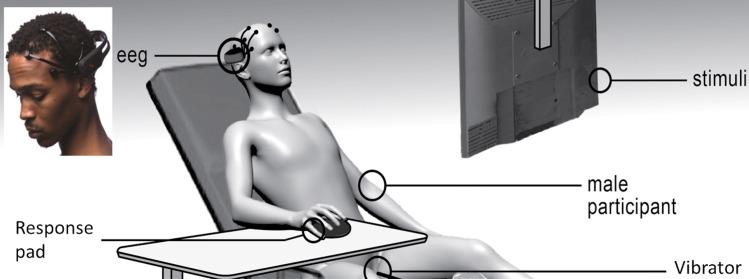
Experiment setup.